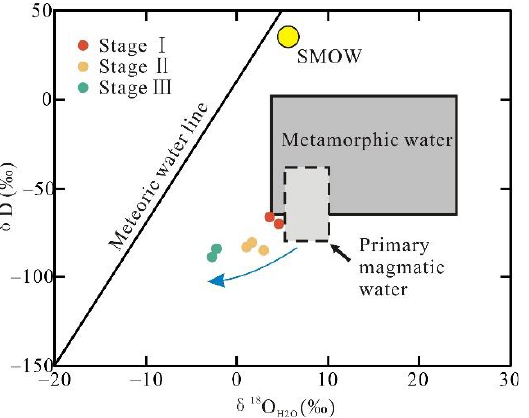
Figure 8. The diagram of hydrogen and oxygen isotopic compositions of the ore fluids for the Tou- daochuan deposit. The magmatic, metamorphic water boxes and meteoric water line are from Tay- lor [50].